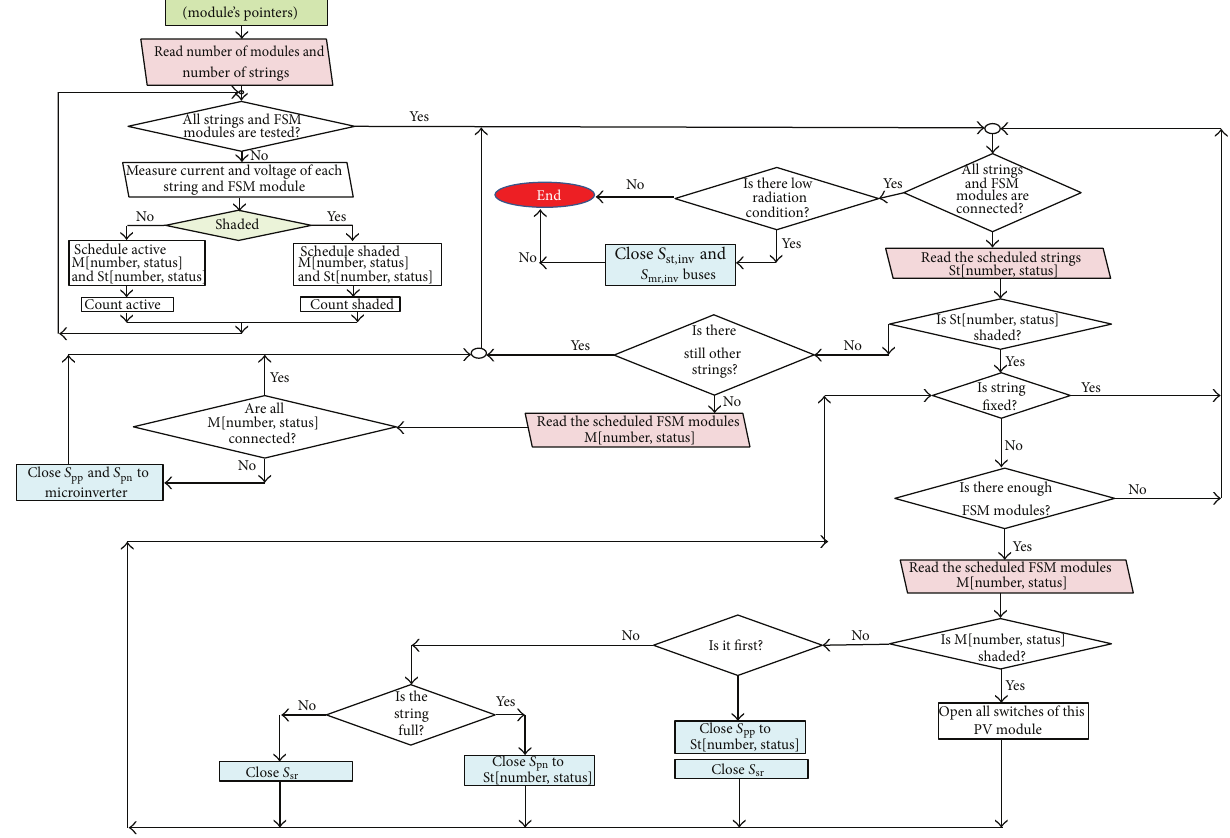
Figure 3: Adaptive PV string-inverter configuration control flow chart.